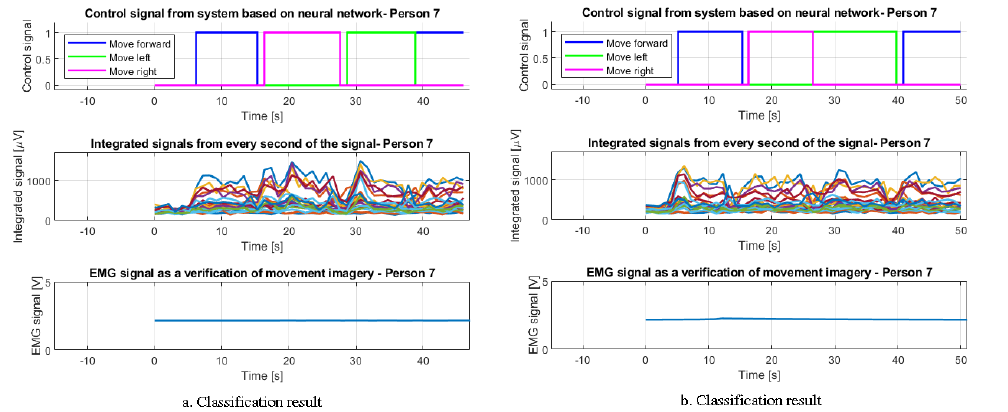
Figure 24. Observation of the signal classification and verification results—Person 7.